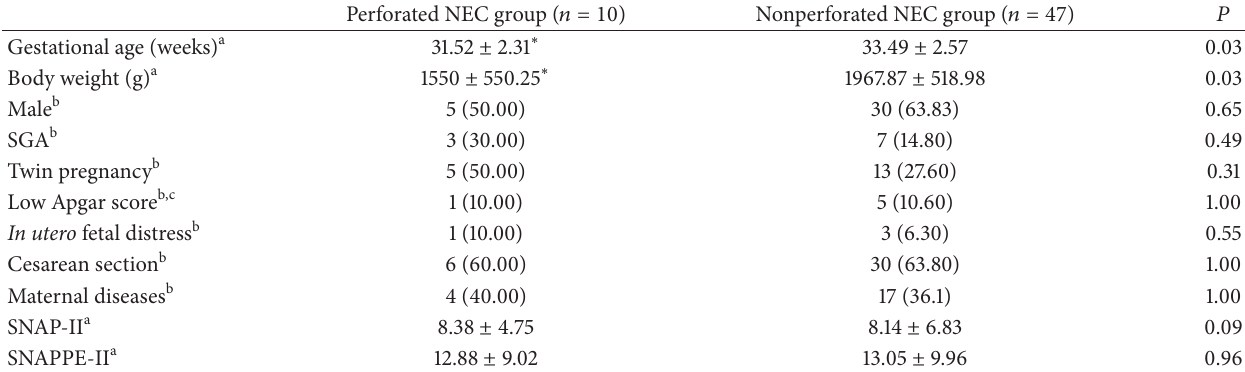
Table 1: General characteristics in NEC infants with and without bowel perforation.